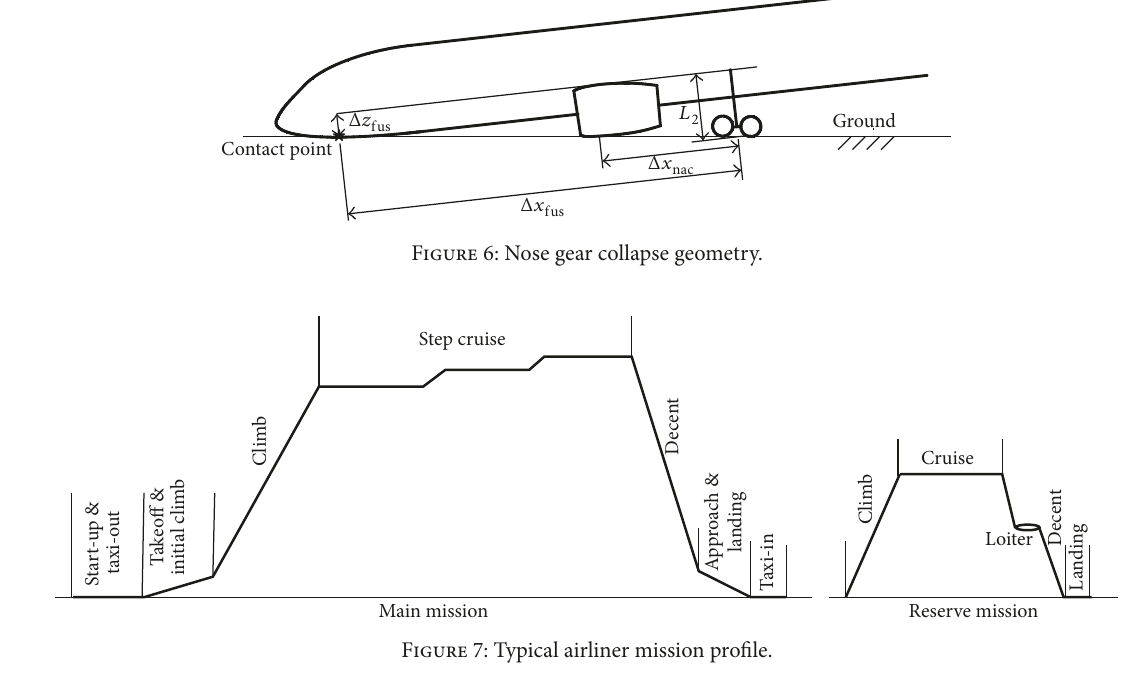
Figure 7: Typical airliner mission profile.